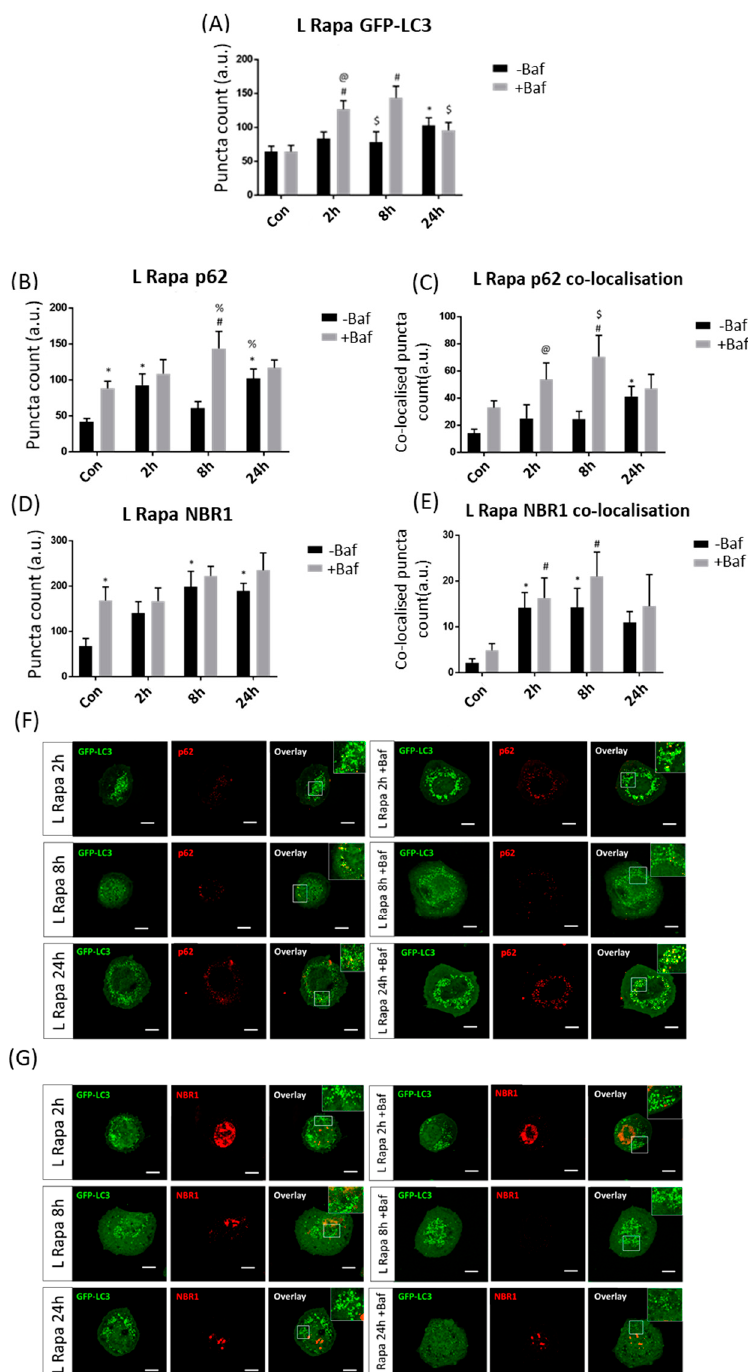
Figure 4. Puncta count analysis following 10 nM rapamycin (L Rapa) over 24 h in the presence (+Baf) and absence ( − Baf) of bafilomycin. ( A ) Total GFP-LC3 puncta analysis. N = 24. * p < 0.05 vs. Con, # p < 0.05 vs. Con +Baf, @ p < 0.05 vs. 2h -Baf, $ p < 0.05 vs. 8h +Baf. ( B ) Total p62 puncta analy- sis. N = 12. * p < 0.05 vs. Con, # p < 0.05 vs. Con +, % p < 0.05 vs. 8h -Baf. ( C ) Co-localised GFP- LC3/p62 puncta analysis. N = 12. * p < 0.05 vs. Con, # p < 0.05 vs. Con +Baf, @ p < 0.05 vs. 2h -Baf, $ p < 0.05 vs. 8h -Baf. ( D ) Total NBR1 puncta analysis. N = 12. * p < 0.05 vs. Con. ( E ) Co-localised GFP-LC3/NBR1 puncta analysis. N = 12. * p < 0.05 vs. Con, # p < 0.05 vs. Con +Baf. ( F ) Representative fluorescence micrographs showing GFP-LC3 and p62 puncta. ( G ) Representa-tive fluorescence micrographs showing GFP-LC3 and NBR1 puncta. Scale bar = 10 µ